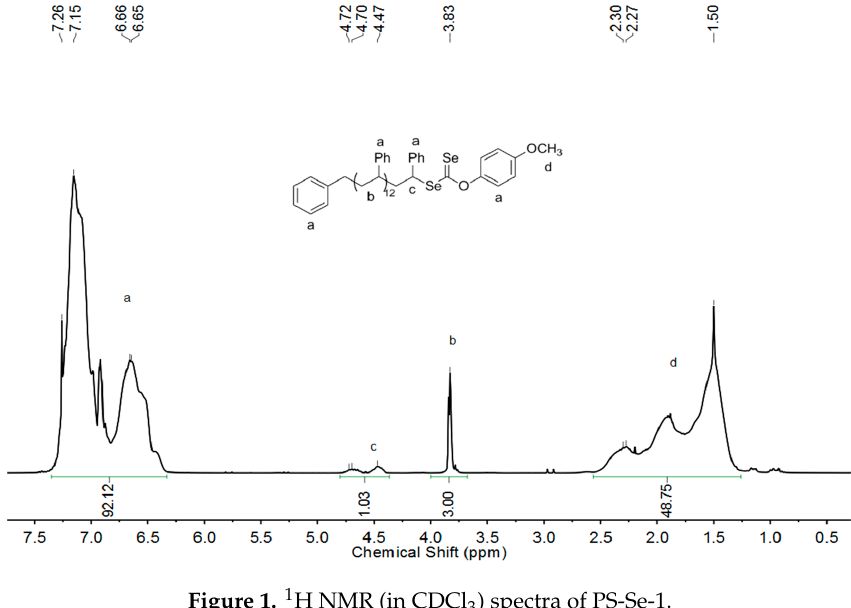
Figure 1. 1 H NMR (in CDCl 3 ) spectra of PS-Se-1.